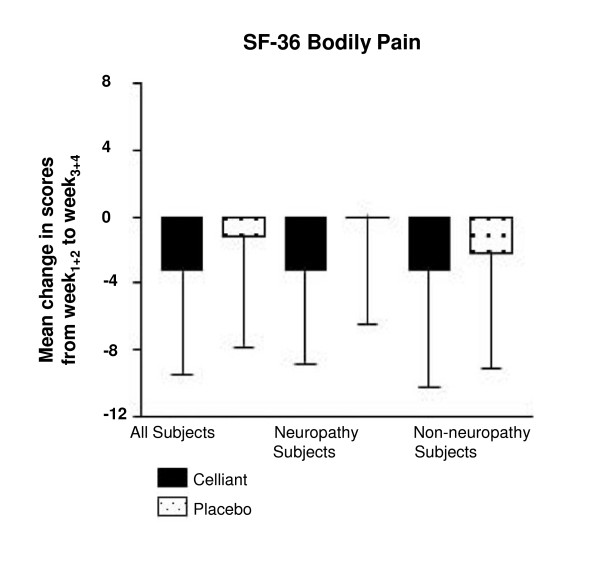
Results of the SF-36 Bodily Pain. The difference between mean W1+2 and mean W3+4 scores is depicted. Solid bars report Celliant™ and stipled bars report control subjects.